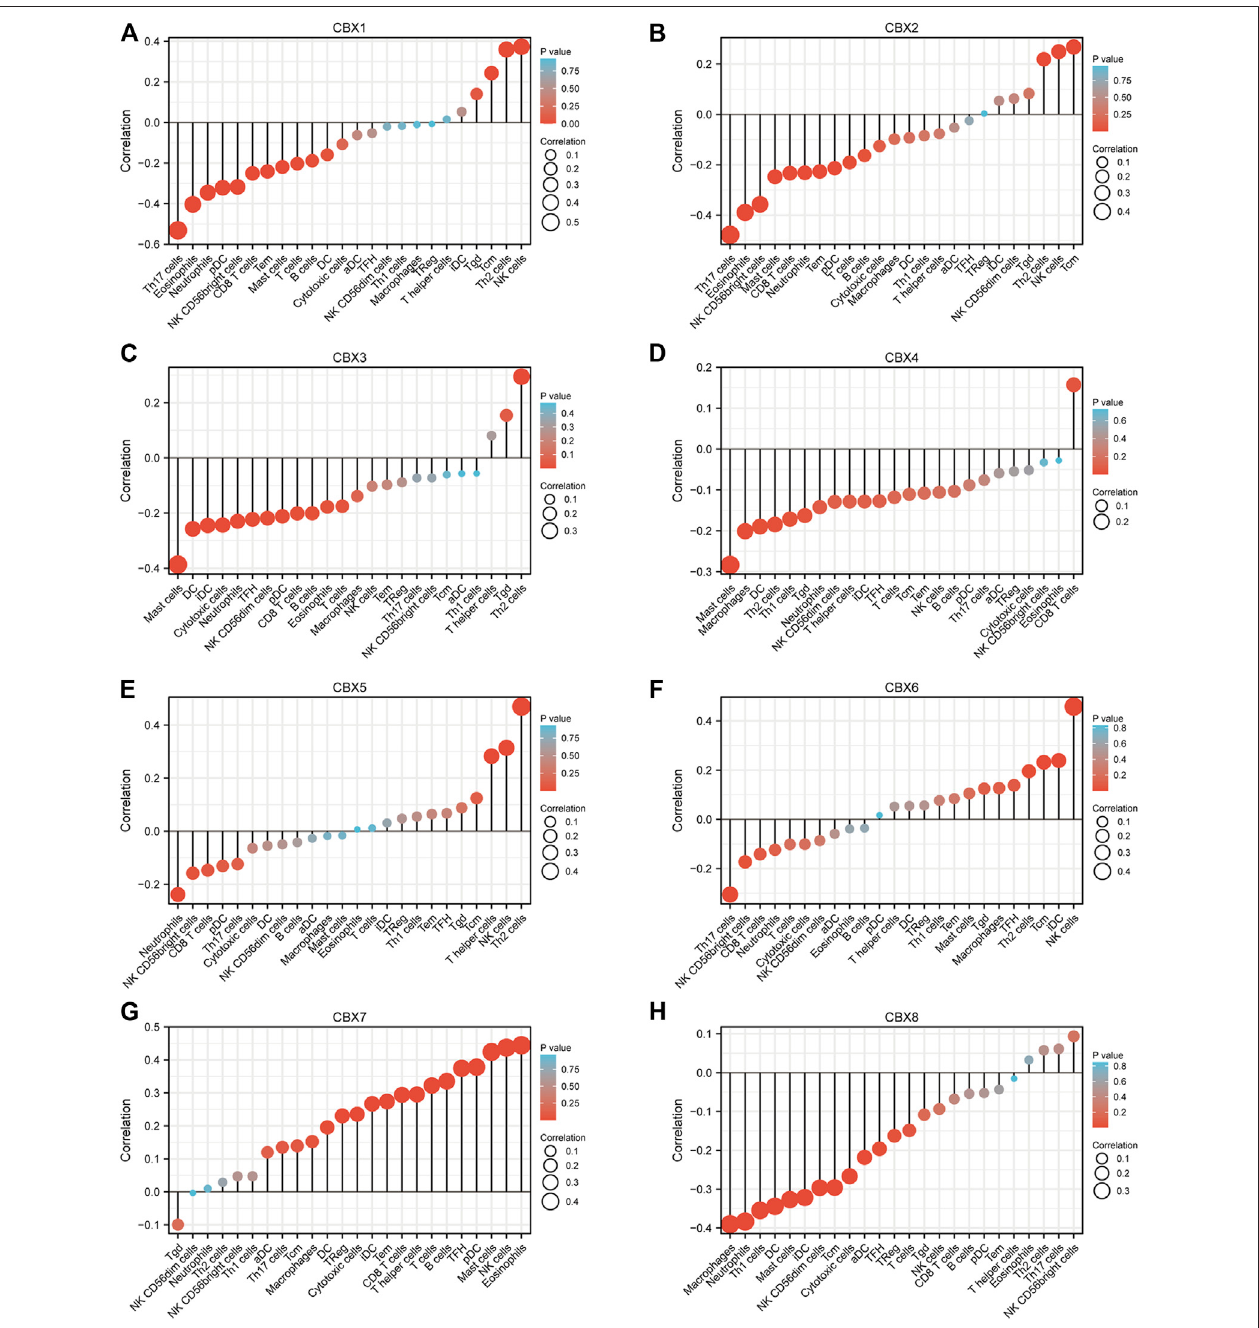
FIGURE 7 | Correlations between differentially expressed CBX family members and immune cell in fi ltrations (TCGA). Correlations between the abundance of immune cells and the expression of CBX1-8 (A – H) .